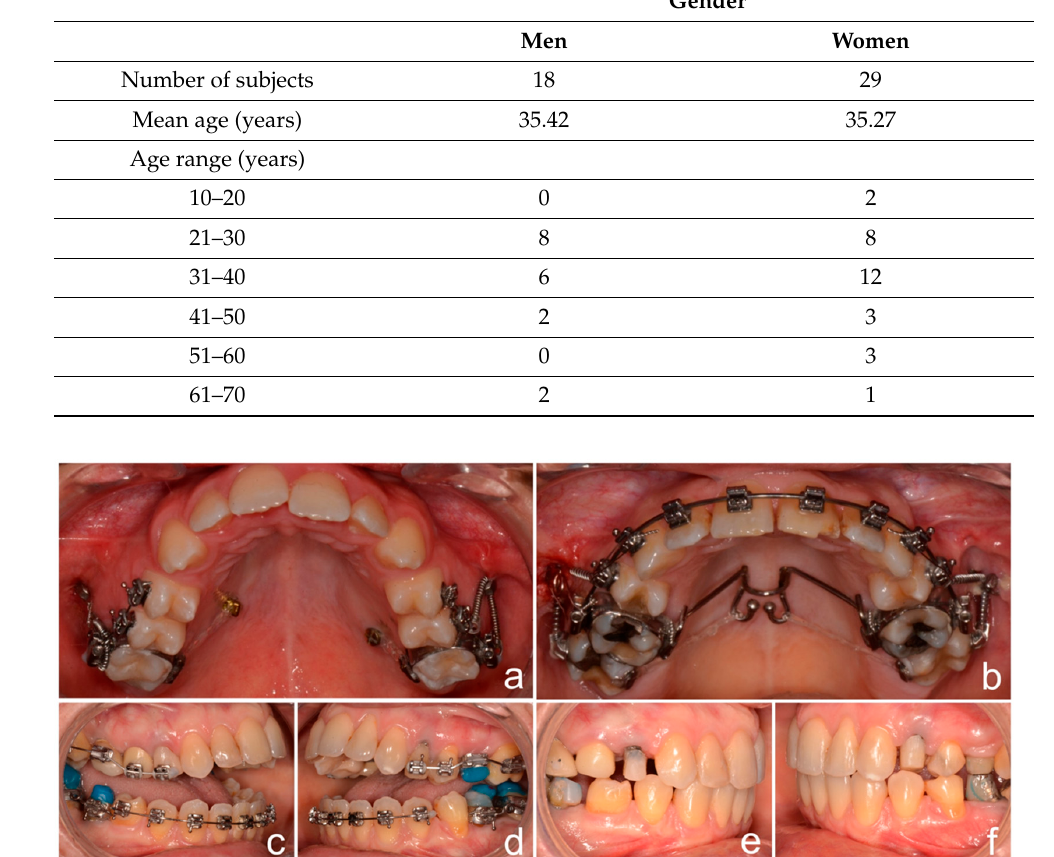
Figure 1. Skeletally anchored molar intrusion. Buccal miniplates combined palatal miniscrews ( a ) or with transpalatal bar ( b ) or bilateral molar dental implants ( c – f ) were used for orthodontic molar intrusion following occlusal splint therapy.